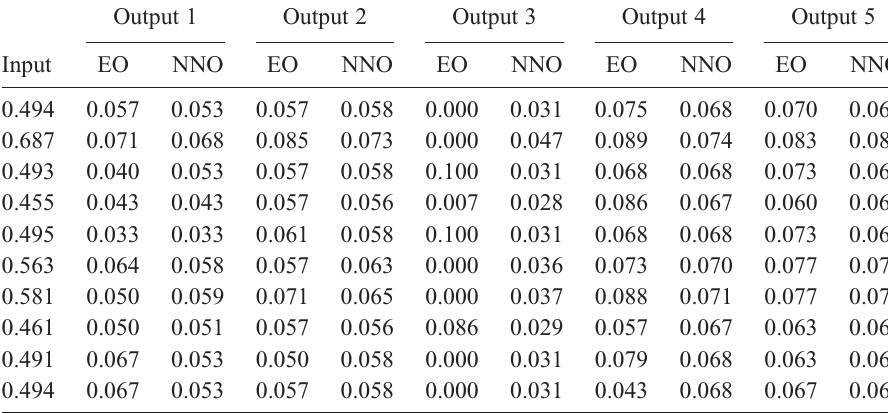
Table 5. The differences between the expected and predicted results for the second multi- layer perceptron model (one input, five